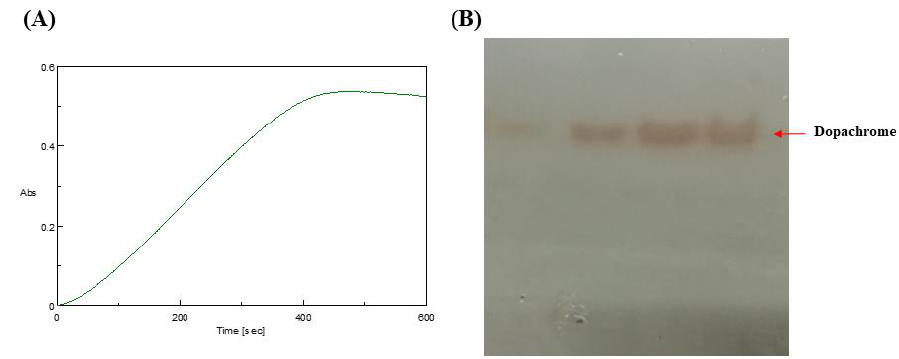
Figure 3. ( A ) Change in absorbance was monitored at 473 nm (dopachrome λ max = 473). ( B ) Do- pachrome was formed upon addition of tyrosine as substrate in an enzyme mixture proving the active form of tyrosinase in reaction mixture. Native-PAGE gel was incubated in 5 mM L-tyrosine (substrate) at 37 °C, and bands of light red-colored pigment dopachrome (shown right side) were appeared after a few minutes of incubation, which eventually leads to production of melanin dark brown color (shown in Figure 3 right side).